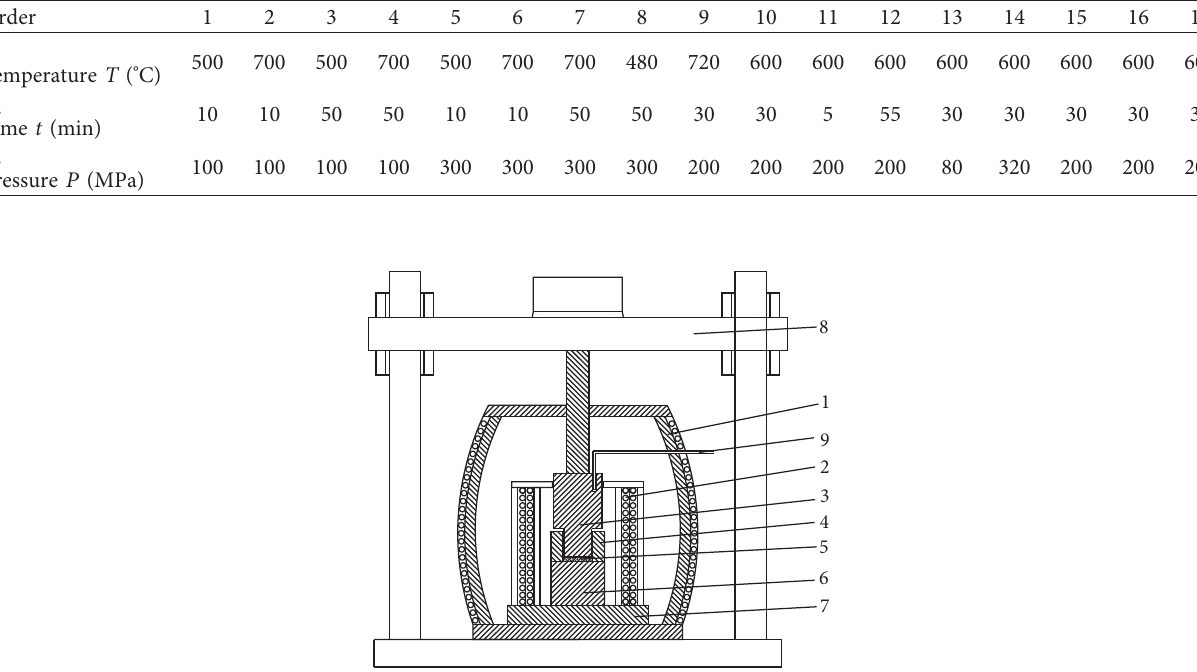
Figure 2: The diagram of the hot-pressing technique in a vacuum environment. 1, vacuum chamber; 2, heating furnace; 3, pestle; 4, shell mold; 5, pressing material; 6, mortar; 7, pedestal; 8, pressing table; 9,